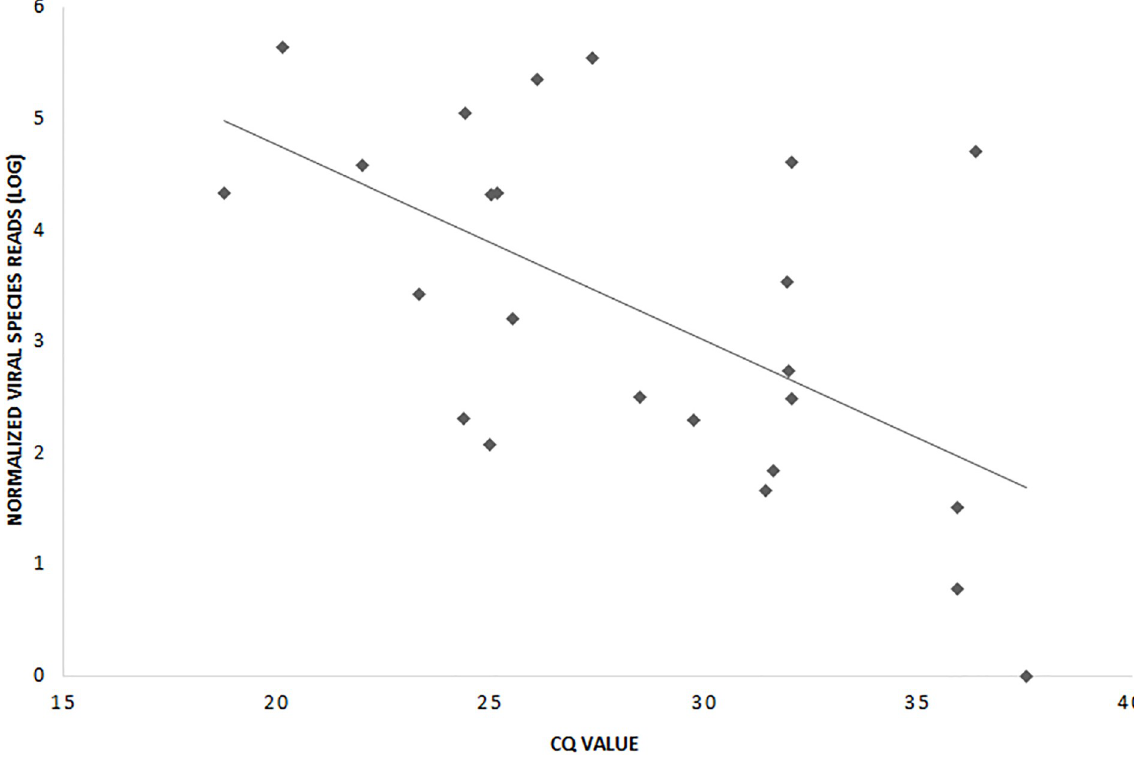
Fig 3. Correlation between mNGS normalized viral species reads (log) and Cq value ( ρ = -0.6, p = 0.002).